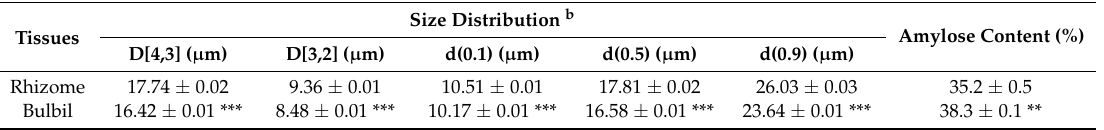
Figure 1. Morphology under normal light ( A , a ) and polarized light ( B , b ) and size distribution ( C , c ) of starch granules from rhizome ( A – C ) and bulbil ( a – c ) of Chinese yam. Scale bar = 20 μ m. Table 2. Granule size distribution and amylose content of starches a .